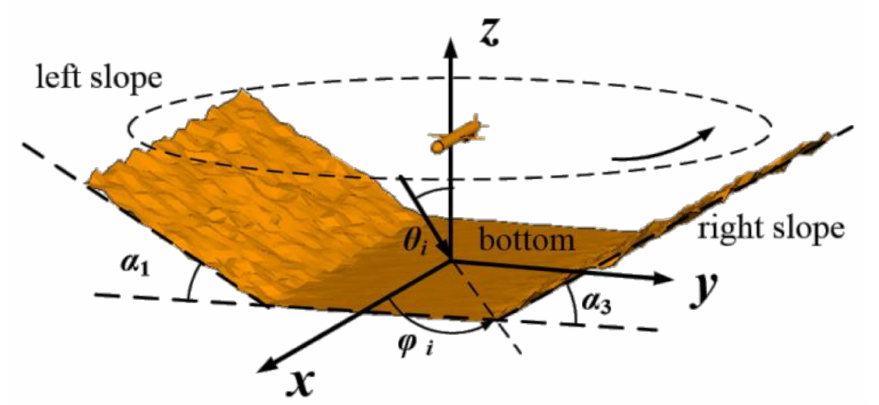
Figure 17. The geometry of a missile-like target above composite rough surface for monostatic